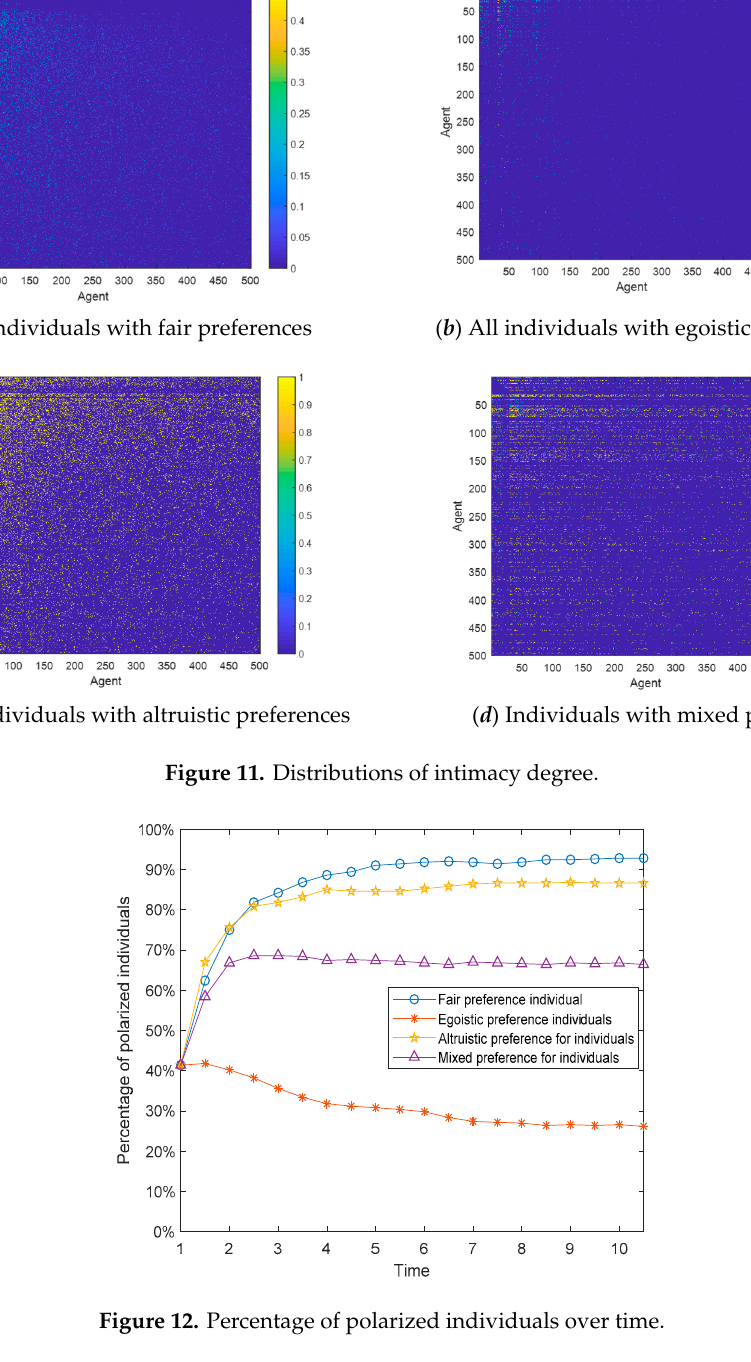
Figure 12. Percentage of polarized individuals over time.